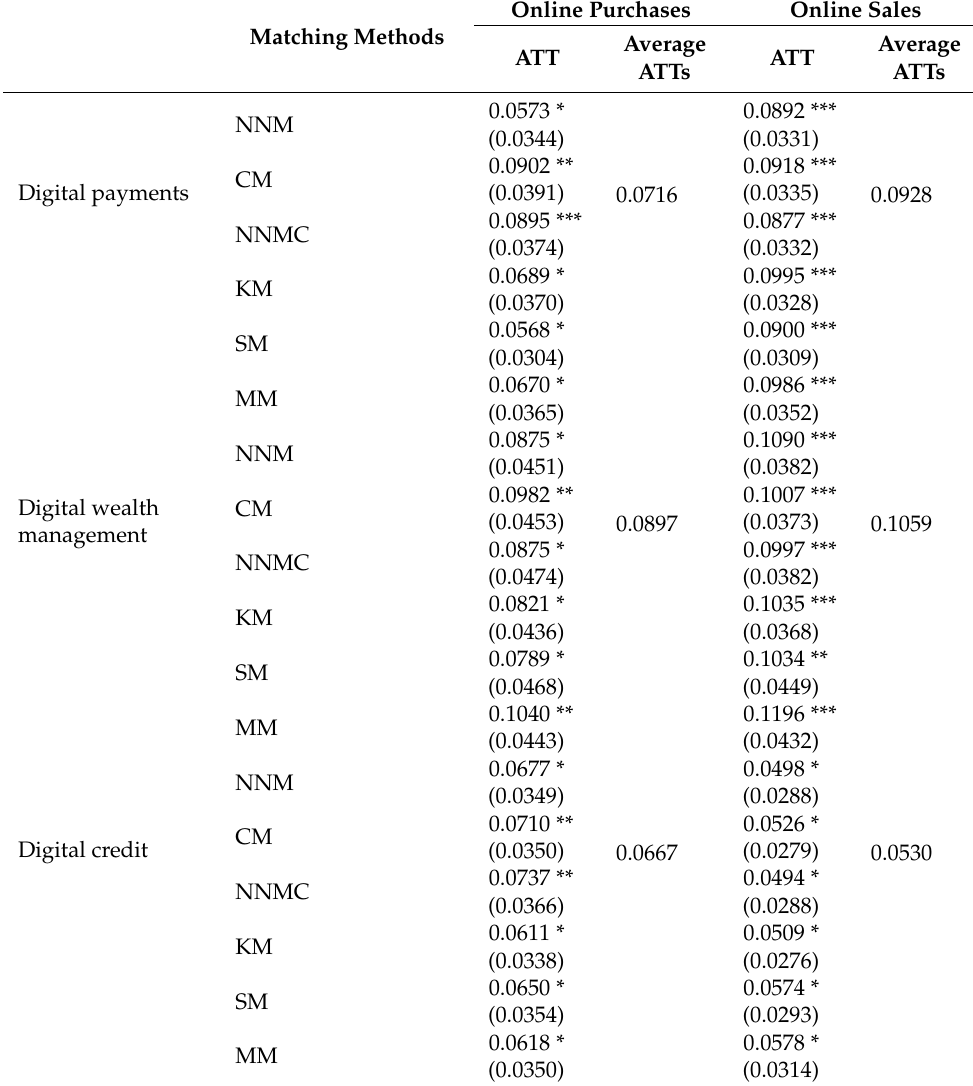
Table 2. PSM estimation of the impact of e-commerce adoption on usage of digital